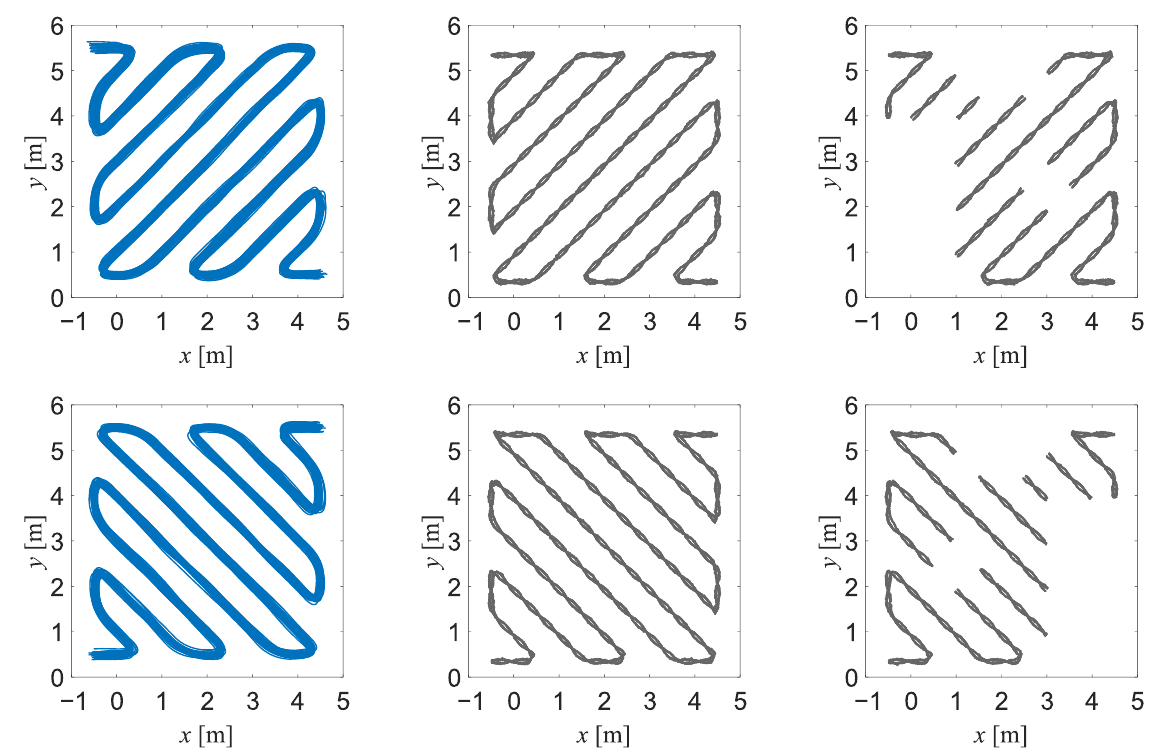
Figure 3. Synthetic data used for training the neural networks: the radar data ( left column ), the depth data without occlusion ( middle column ) and the depth data with occlusion ( right column ). Each graph for radar data depicts 40 superimposed sequences of synthetic data, while each graph for depth data depicts 20 superimposed sequences of synthetic data.